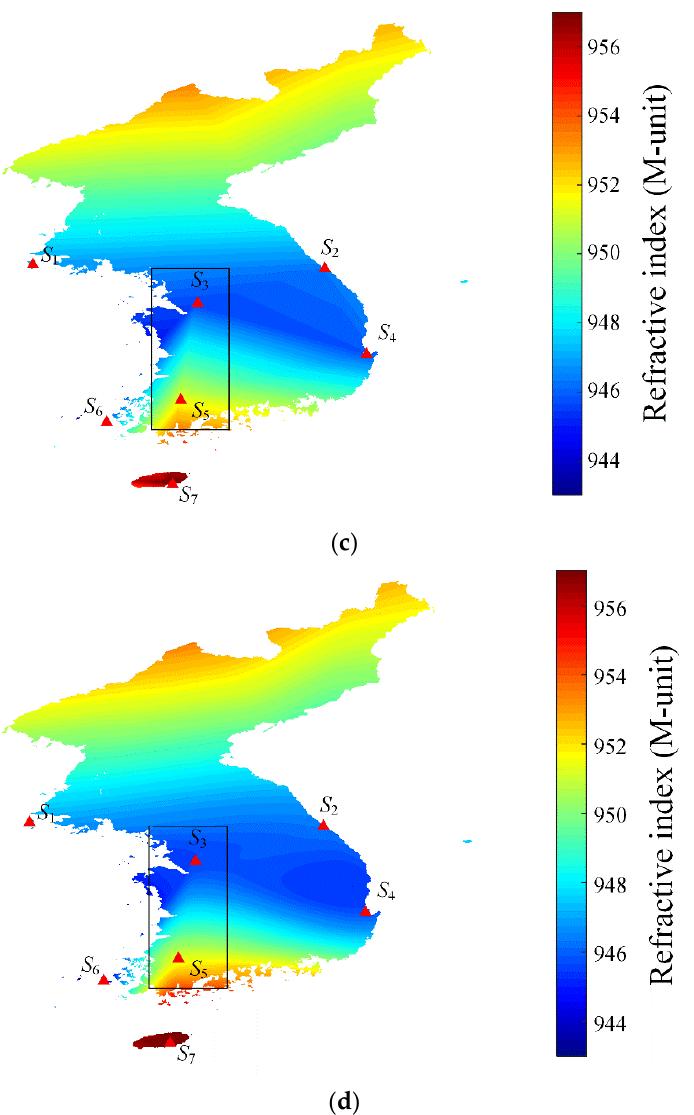
Figure 4. Two-dimensional interpolation results at a fixed altitude of 5000 m in the Korean Peninsula (15 February 2019): ( a ) IDW method; ( b ) nearest-neighbor method; ( c ) linear method; ( d ) cubic method.